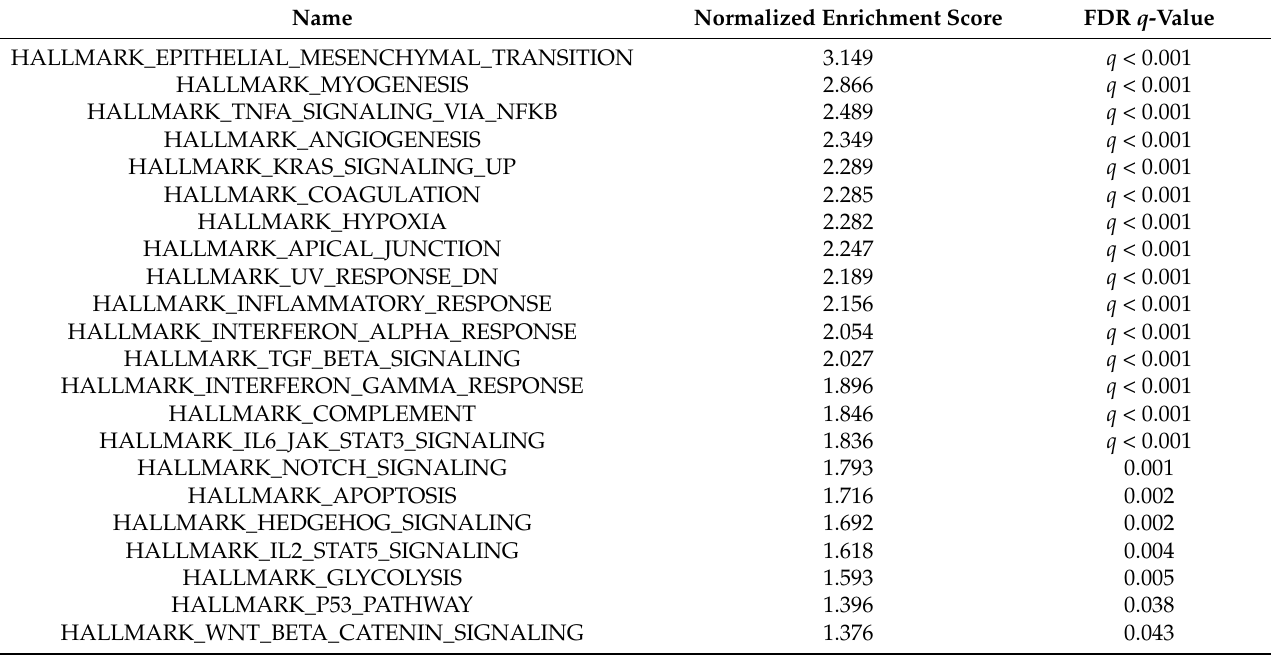
Table 2. The significantly enriched gene sets in the high SERPINE1 expression group in